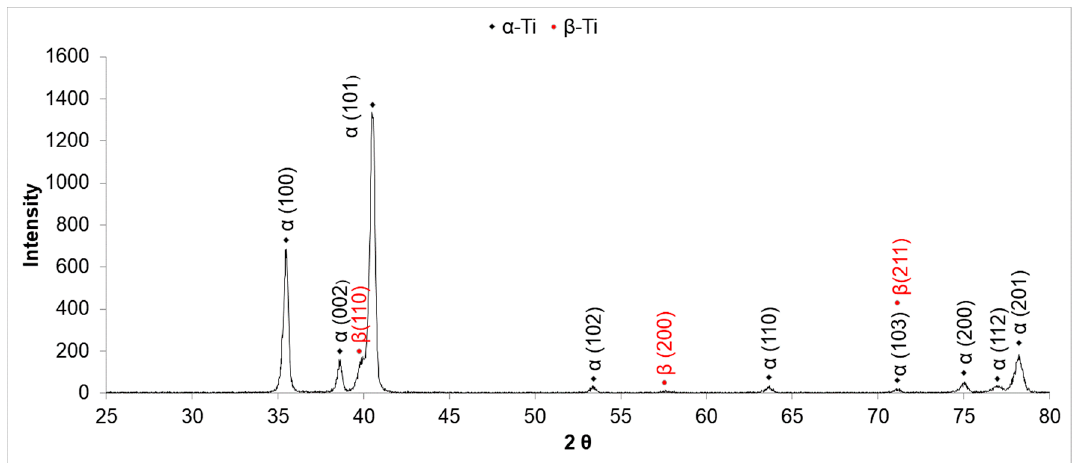
Figure 7. X-ray diffraction (XRD) pattern of the untreated Ti-6Al-4V sample.